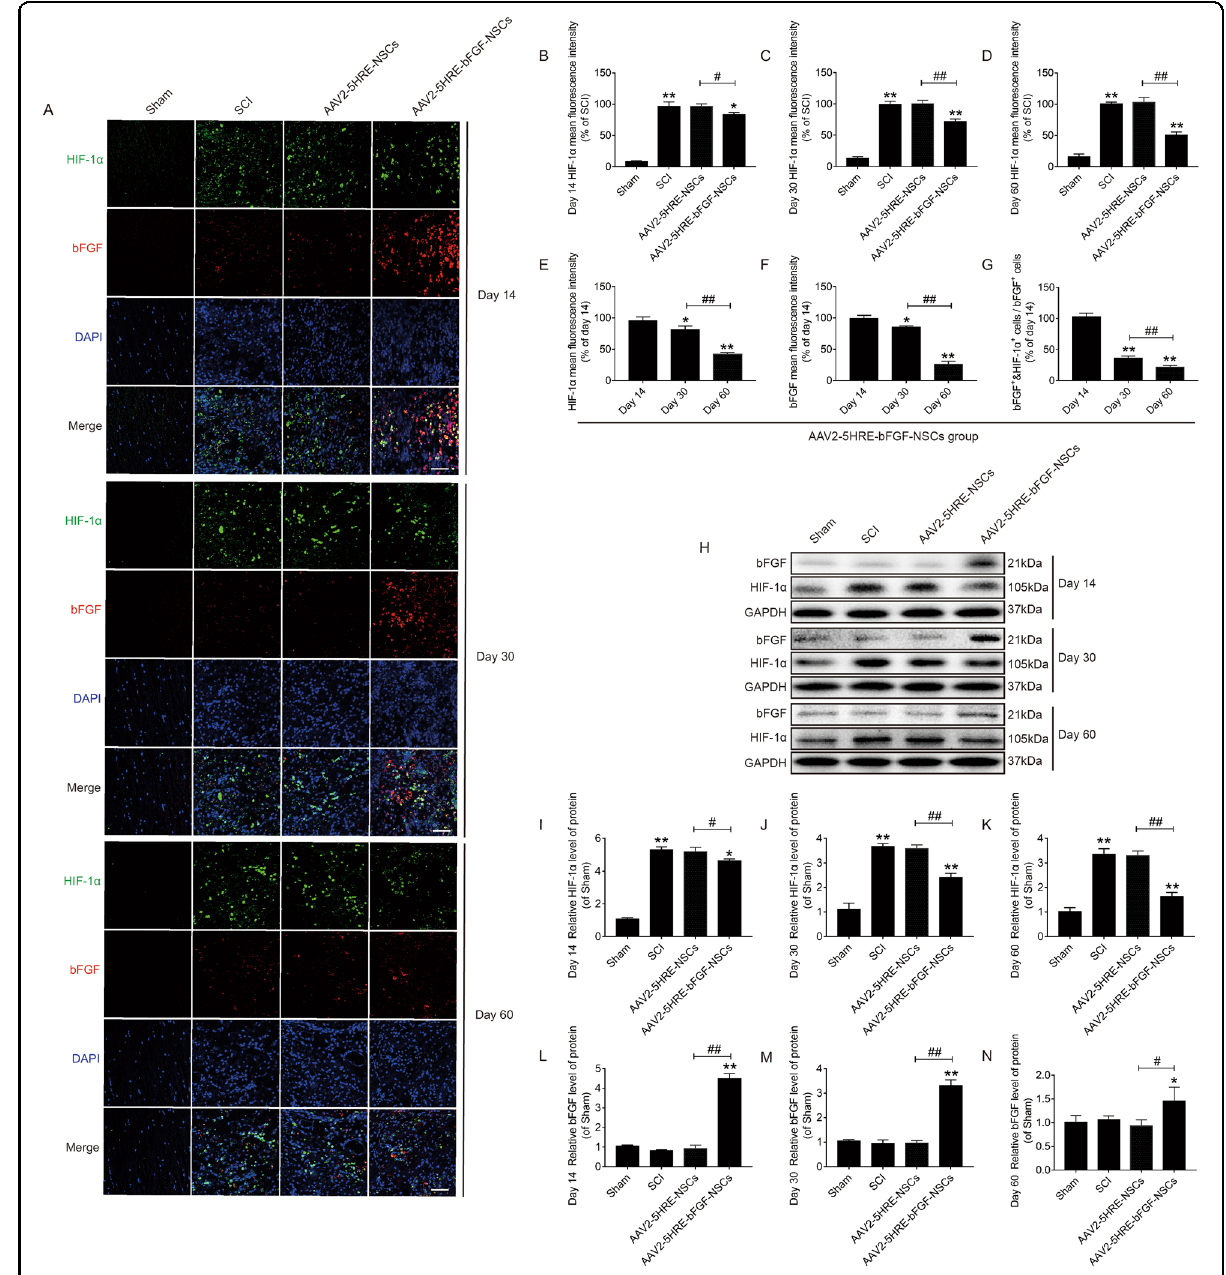
Fig. 4 AAV2-5HRE-bFGF-NSCs show temporally increased expression of bFGF in SCI rats under the regulation of hypoxia. A Immuno fl uorescence staining of bFGF and HIF-1 α in the sham group, SCI group, AAV2-5HRE-NSCs group and AAV-5HRE-bFGF-NSCs group in day 14, day 30 and day 60. The bright green signals indicate positive staining for bFGF. The bright red signals denote positive staining for HIF-1 α . The nuclear is labeled by DAPI (blue), magni fi cation was ×40. Scale bar = 50 µm. B – D Comparison of the fl uorescence intensity of HIF-1 α positive cells by immuno fl uorescence staining. E Comparison of the fl uorescence intensity of HIF-1 α positive cells by immuno fl uorescence staining in day 14, day 30, and day 60 of AAV-5HRE-bFGF-NSCs group. F Comparison of the fl uorescence intensity of bFGF positive cells by immuno fl uorescence staining in day 14, day 30, and day 60 of AAV-5HRE-bFGF-NSCs group. G Comparison of the fl uorescence intensity of bFGF + and HIF-1 α + cells in bFGF + cells by immuno fl uorescence staining in day 14, day 30, and day 60 of AAV-5HRE-bFGF-NSCs group. H – N Western blotting results of HIF-1 α and bFGF protein expression levels in sham group, SCI group, AAV2-5HRE-NSCs group, and AAV2-5HRE-bFGF-NSCs group of day 14, day 30, and day 60. GAPDH was used as a reference. “ ** ” represents P < 0.01 or “ * ” represents P < 0.05, versus SCI group in day 14. “ ## ” represents P < 0.01 or “ # ” represents P < 0.05. Data are the mean values± SEM ( n = 3).